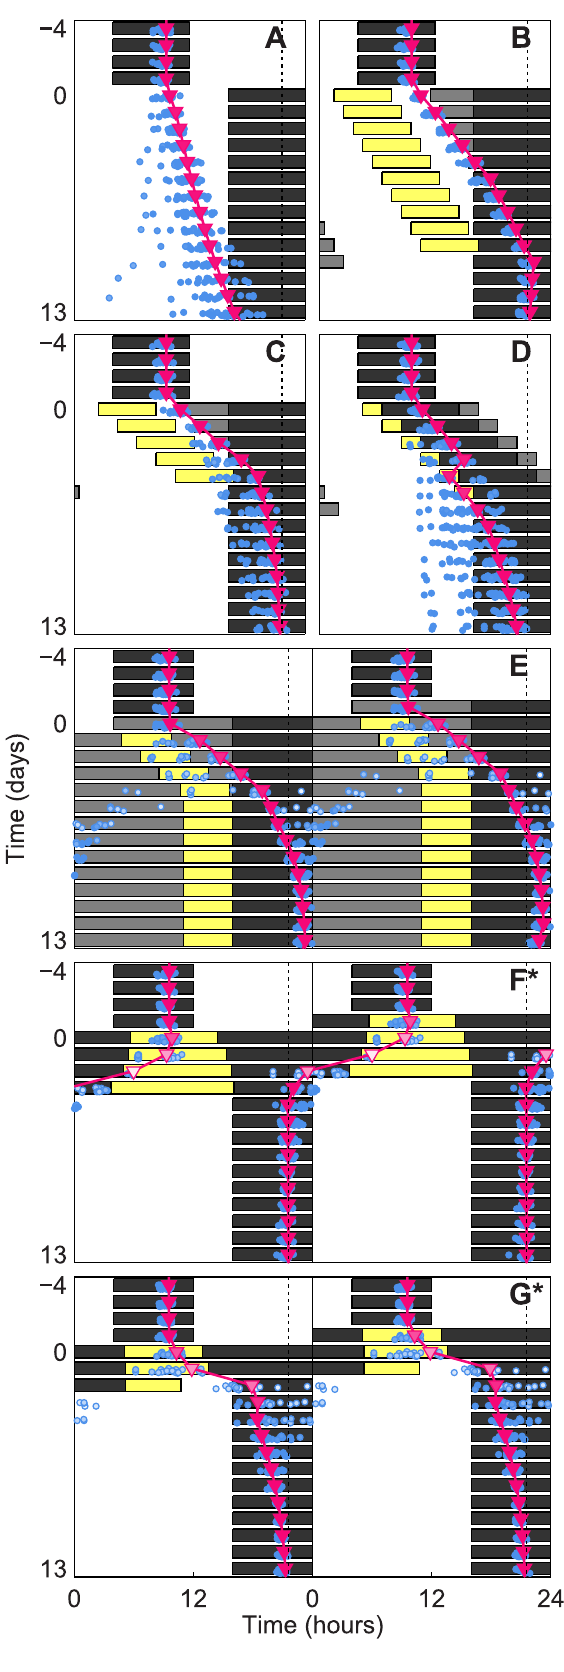
Figure 1. Comparison of schedules for a 12-hour shift of the light-dark cycle. Predicted circadian phase, indicated by simulated core body temperature minima (CBTmin, magenta triangles), is plotted against the pattern of exposure to bright light (10,000 lux, yellow), moderate light (100 lux, white), dim light (5 lux, gray), and darkness (0 lux, black). Predicted CBTmin under noisy light levels (See supplemental figure S1), with circadian period randomly sampled from an experi- mentally measured distribution [18], is plotted for 20 hypothetical subjects (blue circles). Circadian amplitude at CBTmin is indicated by the brightness of the markers, with white corresponding to zero amplitude. The timing of entrained CBTmin in the new time zone is indicated by the dotted line. The subjects are initially entrained to a 16:8 LD-cycle in moderate light. At day 0 the schedule shift occurs. The six schedules are compared are: ( A ) The abruptly shifted LD-cycle; also called a slam shift. ( B ) Times of light exposure and avoidance in the new time zone are prescribed to quicken re-entrainment. Phase delays of 1 hour/day are assumed. Based on the recommendations proposed by R. Sack (See Supplementary Appendix of [49].) ( C ) Times of light exposure and avoidance are prescribed, with an assumed phase delay of 2 hours/day. Based on the recommendations proposed by J. Waterhouse et.al. (See Table 2 of [50].) ( D ) The sleep/dark region is gradually delayed, with 2 hours of bright light before bed and 2 hours of light avoidance after wake. Assumed delay of 2 hours/day. Based on the recommendations proposed by C. Eastman et.al. in [51]. ( E ) A PRC is used to place a series of 5 hour light stimuli, in a background of dim light, in order to produce a large delay. The timings are refined using a model [16]. Proposed by D. Dean et.al. (See Figure S1:E1 in [9].) ( F ) Our optimal schedule for complete re-entrainment in minimum time. A model [16] is used to compute the mathematically optimal schedule of light exposure (See Methods) which resets the model in the least possible amount of time. ( G ) Our optimal schedule for partial re- entrainment in minimum time, designed to place CBTmin at the beginning of the sleep/dark region as quickly as possible (See Designing schedules for Partial Reentrainment in supplemental text